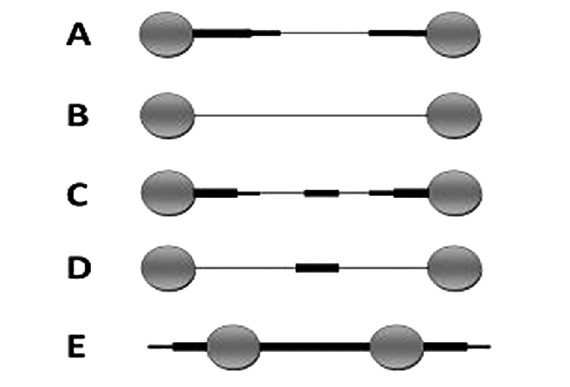
Fig. 1. Basic types of saddle stretch